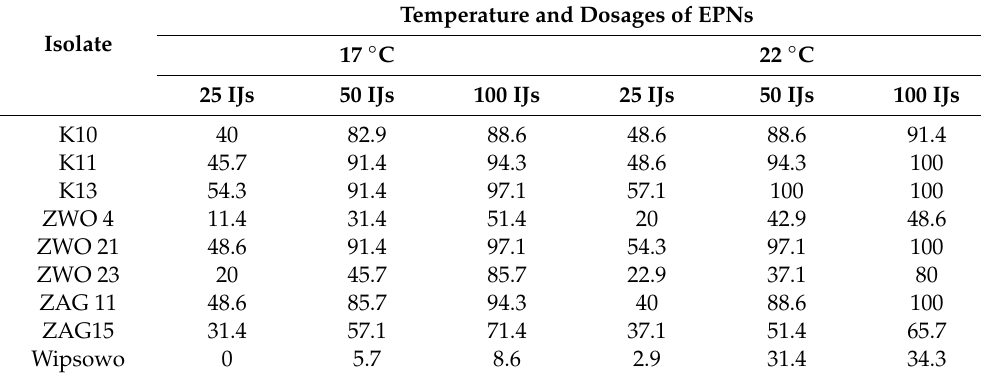
Table 2. The e ff ect of entomopathogenic nematode (EPN) dosages applied at two temperatures on the mortality of the cabbage moth parasitism (%).